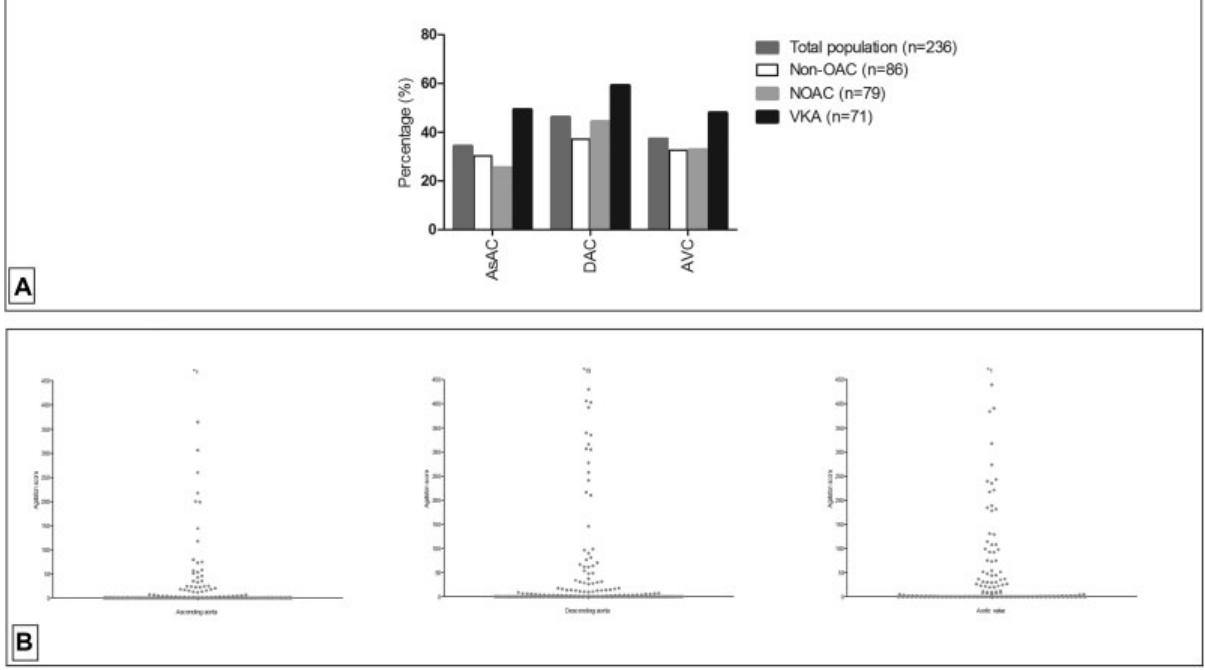
Fig. 1 ( A ) Presence of calci fi cation in different segments in total population and according to treatment type. ( B ) Distribution of calci fi cation (Agatston scores) in the ascending aorta, descending aorta, and aortic valve in the total population. ( “ (cid:3) ” indicates the number of values > 500). AsAC, ascending aortic calci fi cation; DAC, descending aortic calci fi cation; AVC, aortic valve calci fi cation; non-OAC, non-oral anticoagulant; VKA, vitamin K antagonist; NOAC, non – vitamin K antagonist oral anticoagulant.